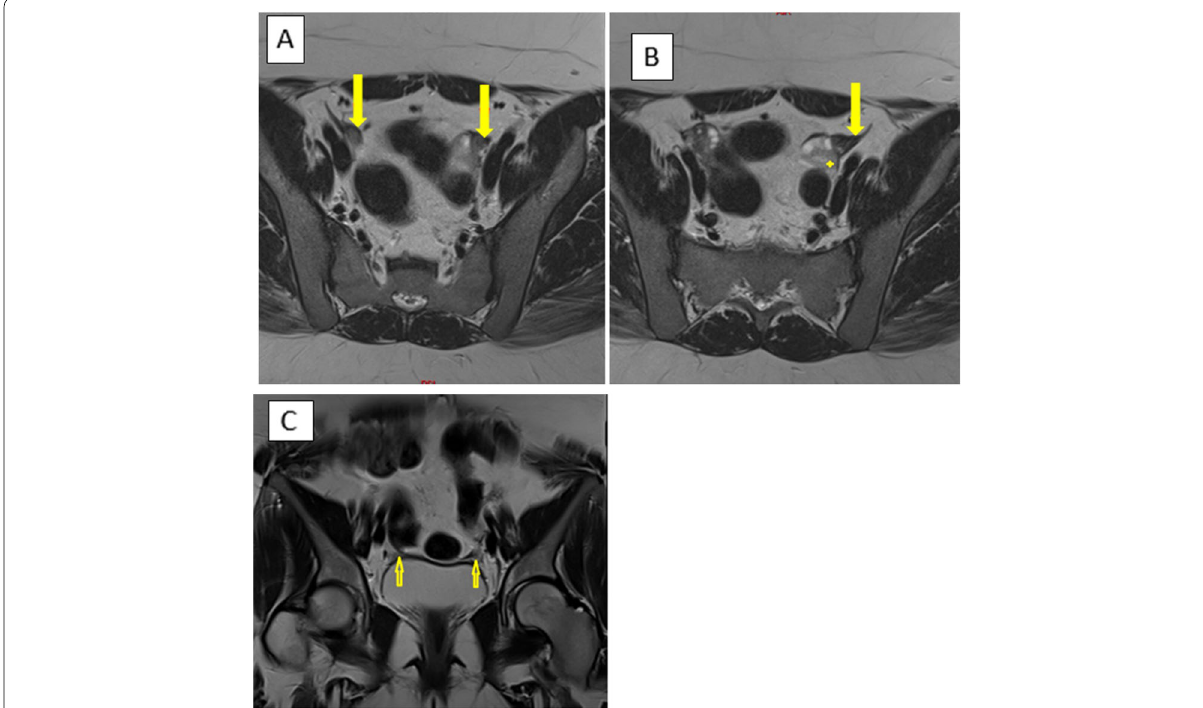
Fig. 3 A – C Axial T2WIs pelvic MRI: A , B showed the lateral uterine bud (closed yellow arrow) located lateral high in the pelvis and abutting the ovaries (yellow star). C Fibrous bands seen bilaterally above dome of the bladder (yellow open